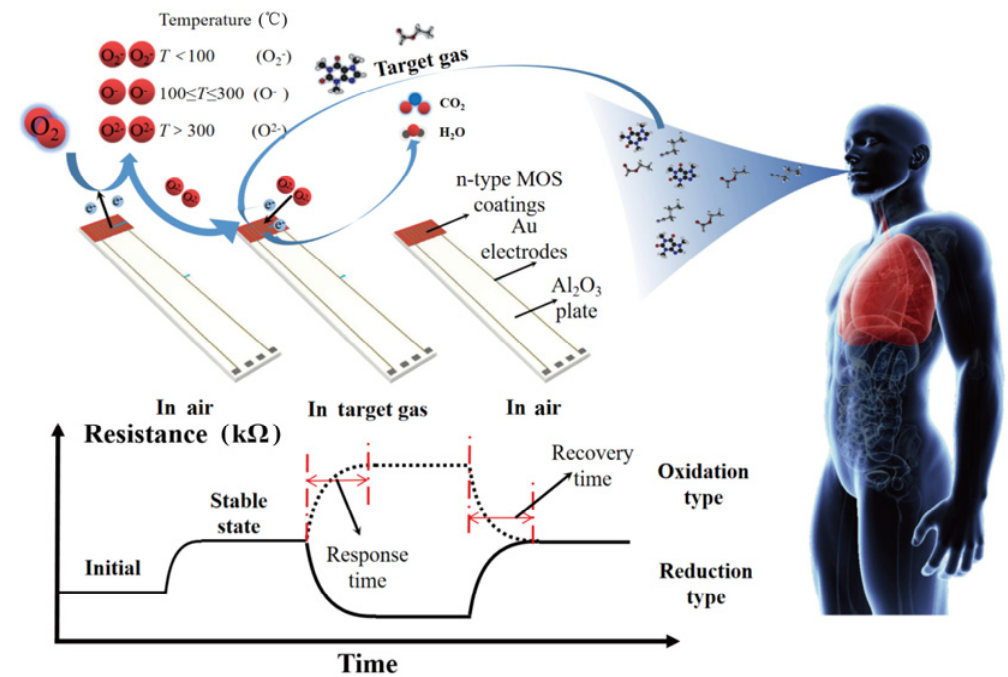
Fig. 2 Working mechanism of n-type metal oxide gas sensors for LC